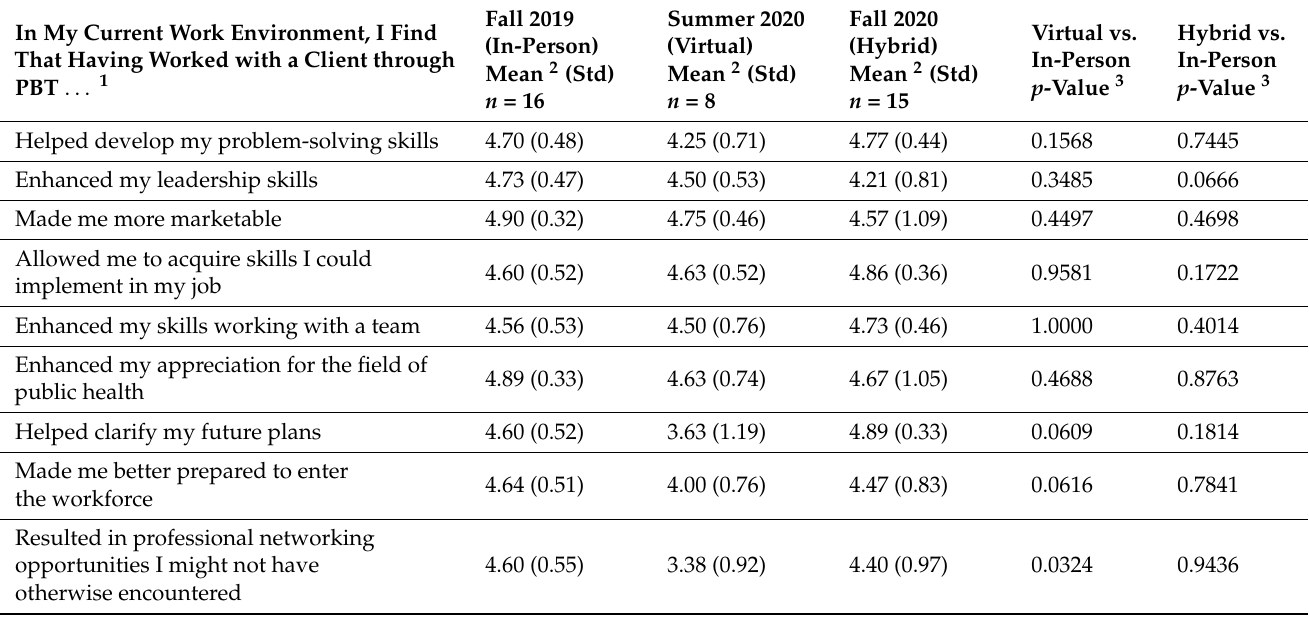
Table 4. Post-Course Student Perceptions on Workforce Readiness across Three Semesters of PBT Course: In-Person, Virtual, and Hybrid ( n =